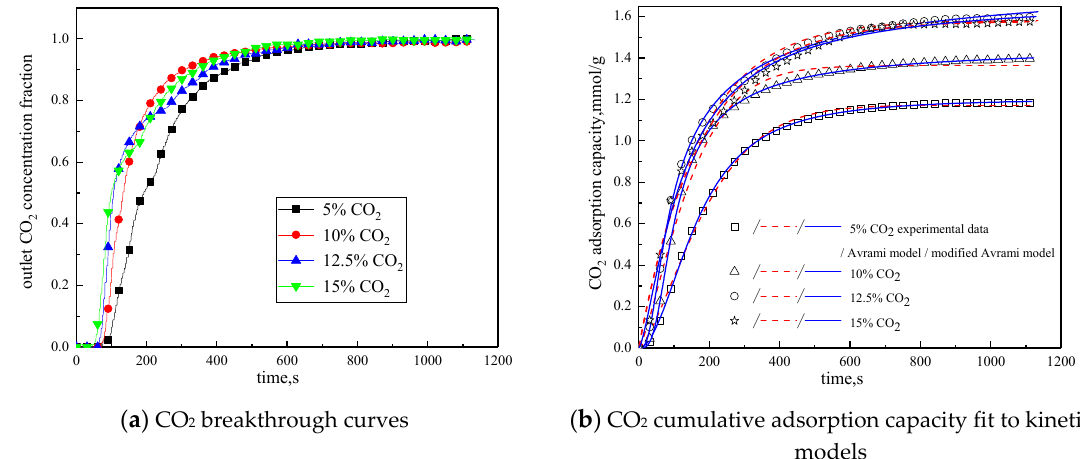
Figure 9. Adsorption characteristics and model fitting results with different CO 2 concentrations. Table 7. Fitting parameters of experimental data for adsorption characteristics under different CO 2